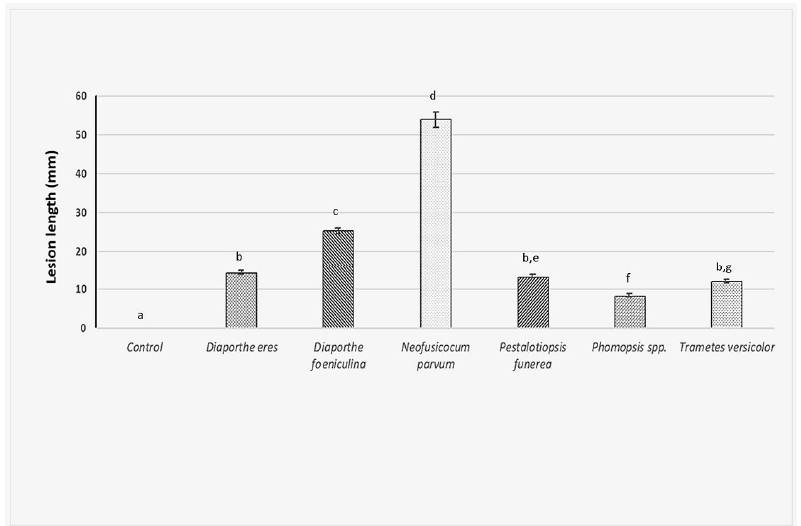
Figure 5. Results of artificial inoculation of the apple twigs with the six fungal isolates investigated. The length of the lesions developed was measured 1 month after inoculation. The experiment was carried out only once with three replications (twigs) and four wounds per replicate. Columns in- dicate the average length of the lesions with standard errors. Means followed by different letters are significantly different according to Tukey’s test ( p =